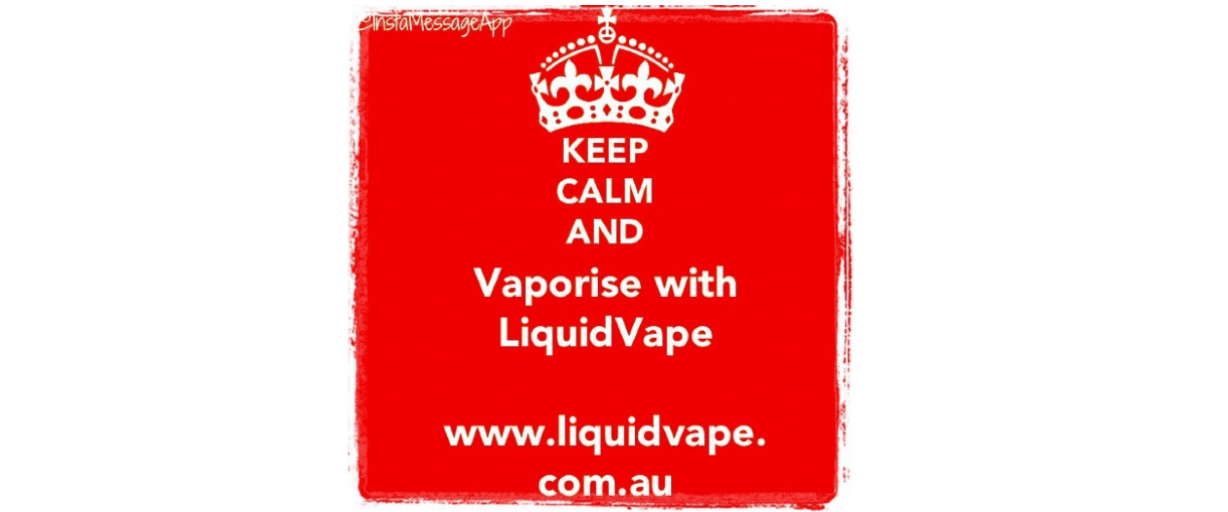
Figure 1. Example within the business listing category of the "promotional practices and strategies" domain.